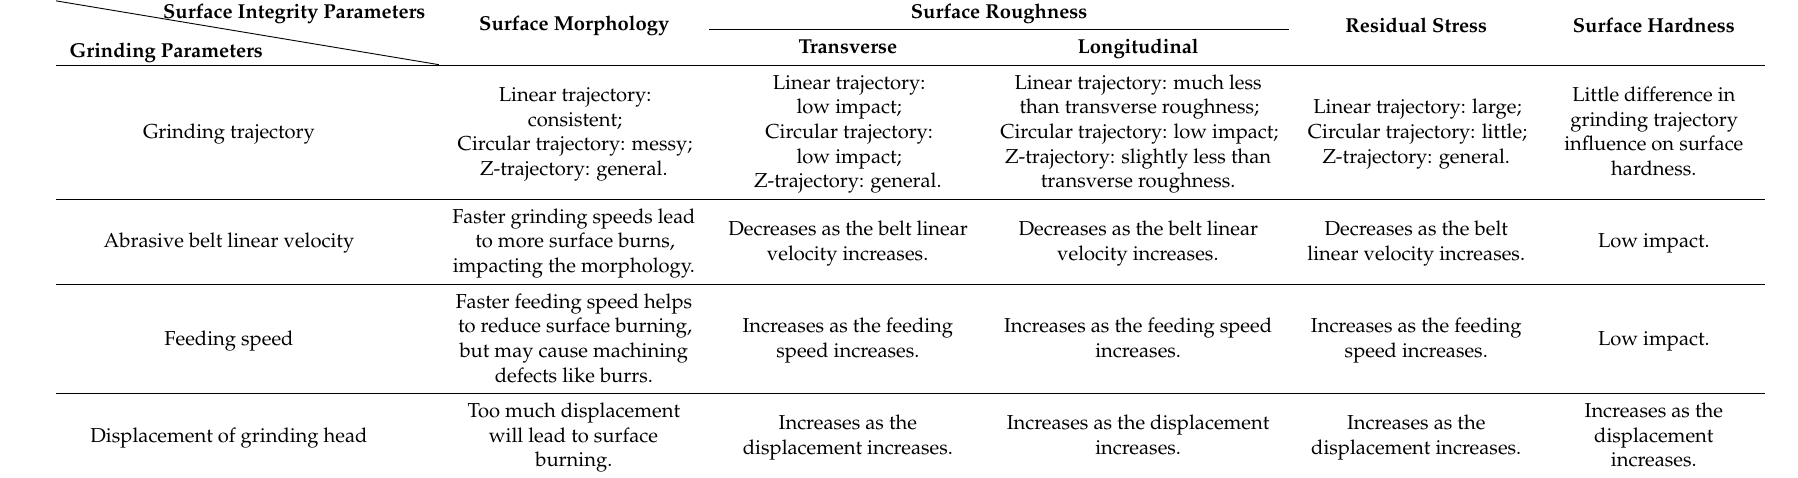
Table 6. Coupling relationship between the surface integrity parameters and the grinding